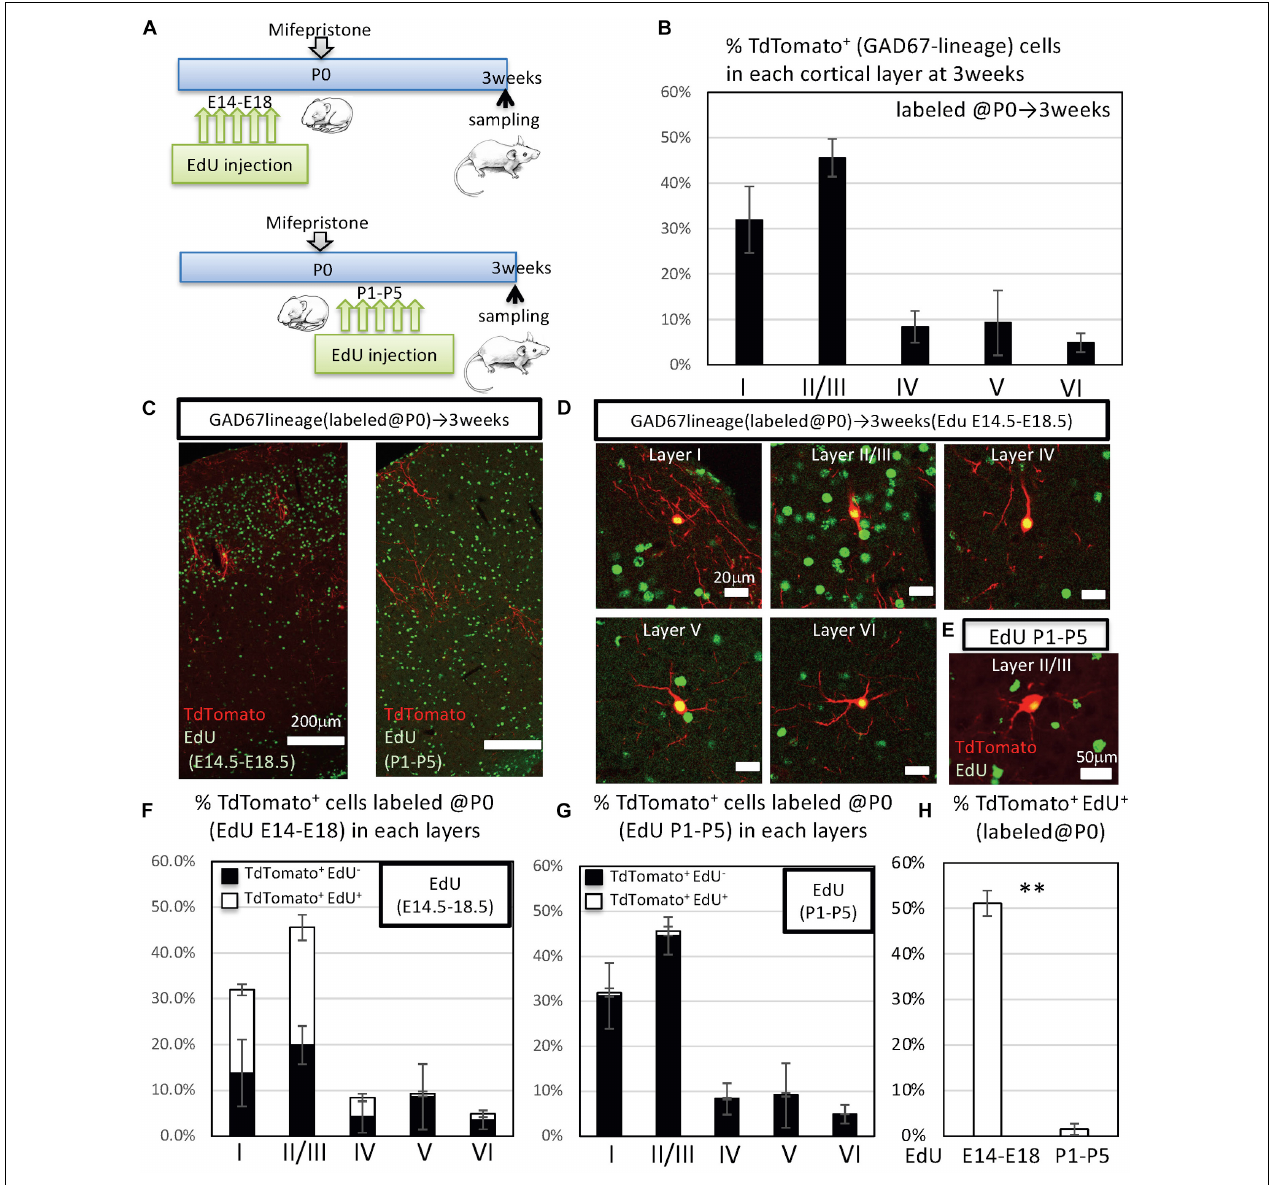
FIGURE 2 | Fate mapping analysis of GAD67 + IPGNs using GAD67-CrePR mouse labeled at P0. (A) Experimental design for labeling IPGNs at the perinatal stage. Mifepristone was administered to pregnant GAD67-CrePR;Ai9 mice at P0, and EdU was injected i.p. from E14.5 to E18.5 or P1 to P5. Mifepristone- and EdU-treated mice were analyzed at 3 weeks of age. IPGNs, intermediate GABAergic neuron progenitors. (B) Percentages of TdTomato + GAD67-lineage cells in each cortical layer labeled at P0. Error bars represent SDs ( n = 9 brains). (C) Coronal section of GAD67-CrePR;Ai9 mice brain at 3 weeks with EdU staining (green). EdU was injected E14.5–E18.5 (left) P1–P5 (right) by dual-fluorescence immunohistochemistry. Immunocytochemical analyses were performed with confocal laser microscopy. (D) Representative images of TdTomato + GAD67-lineage cells labeled at P0 (red) with EdU (E14–18) (green) in each cortical layer at 3 weeks of age. (E) Representative image of TdTomato + GAD67-lineage cells labeled at P0 (red) with EdU (P1–P5) (green) in cortical layer II/III at 3 weeks of age. (F) Percentages of TdTomato + cells (GAD67 lineage labeled at P0) labeled with EdU (E14–E18) in each cortical layer. Error bars represent SDs ( n = 3 brains). (G) Percentages of TdTomato + cells (GAD67 lineage labeled at P0) labeled with EdU (P1–P5) in each cortical layer. Error bars represent SDs ( n = 6 brains). (H) Percentages of TdTomato + EdU + GAD67-lineage cells labeled at P0 and EdU injected from E14.5 to E18.5 ( n = 3 brains) or P1 to P5 ( n = 6 brains). ∗∗ P < 0.01. Error bars represent